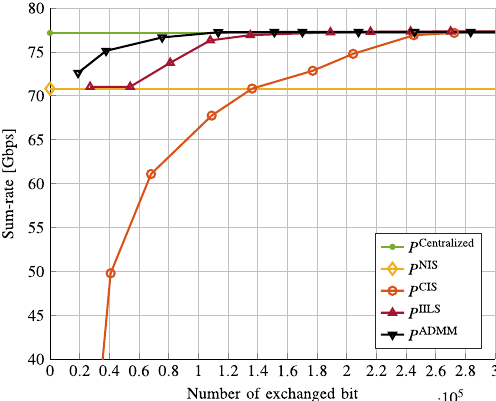
Fig. 3 Sum-rate versus the number of exchanged bits